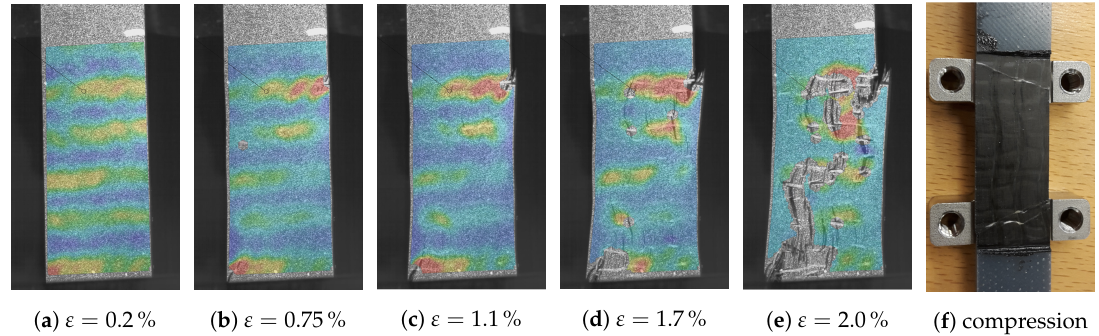
Figure 16. Evolution of deformation under tensile load for an amplitude to wavelength ratio of A / λ ≈ 0.06 ( a )–( e ) and resulting crack after compression for A / λ ≈ 0.03 ( f ). Table 14. Experimental material properties of samples with waviness in different loading directions (all values are medians with the corresponding interquartile range in the